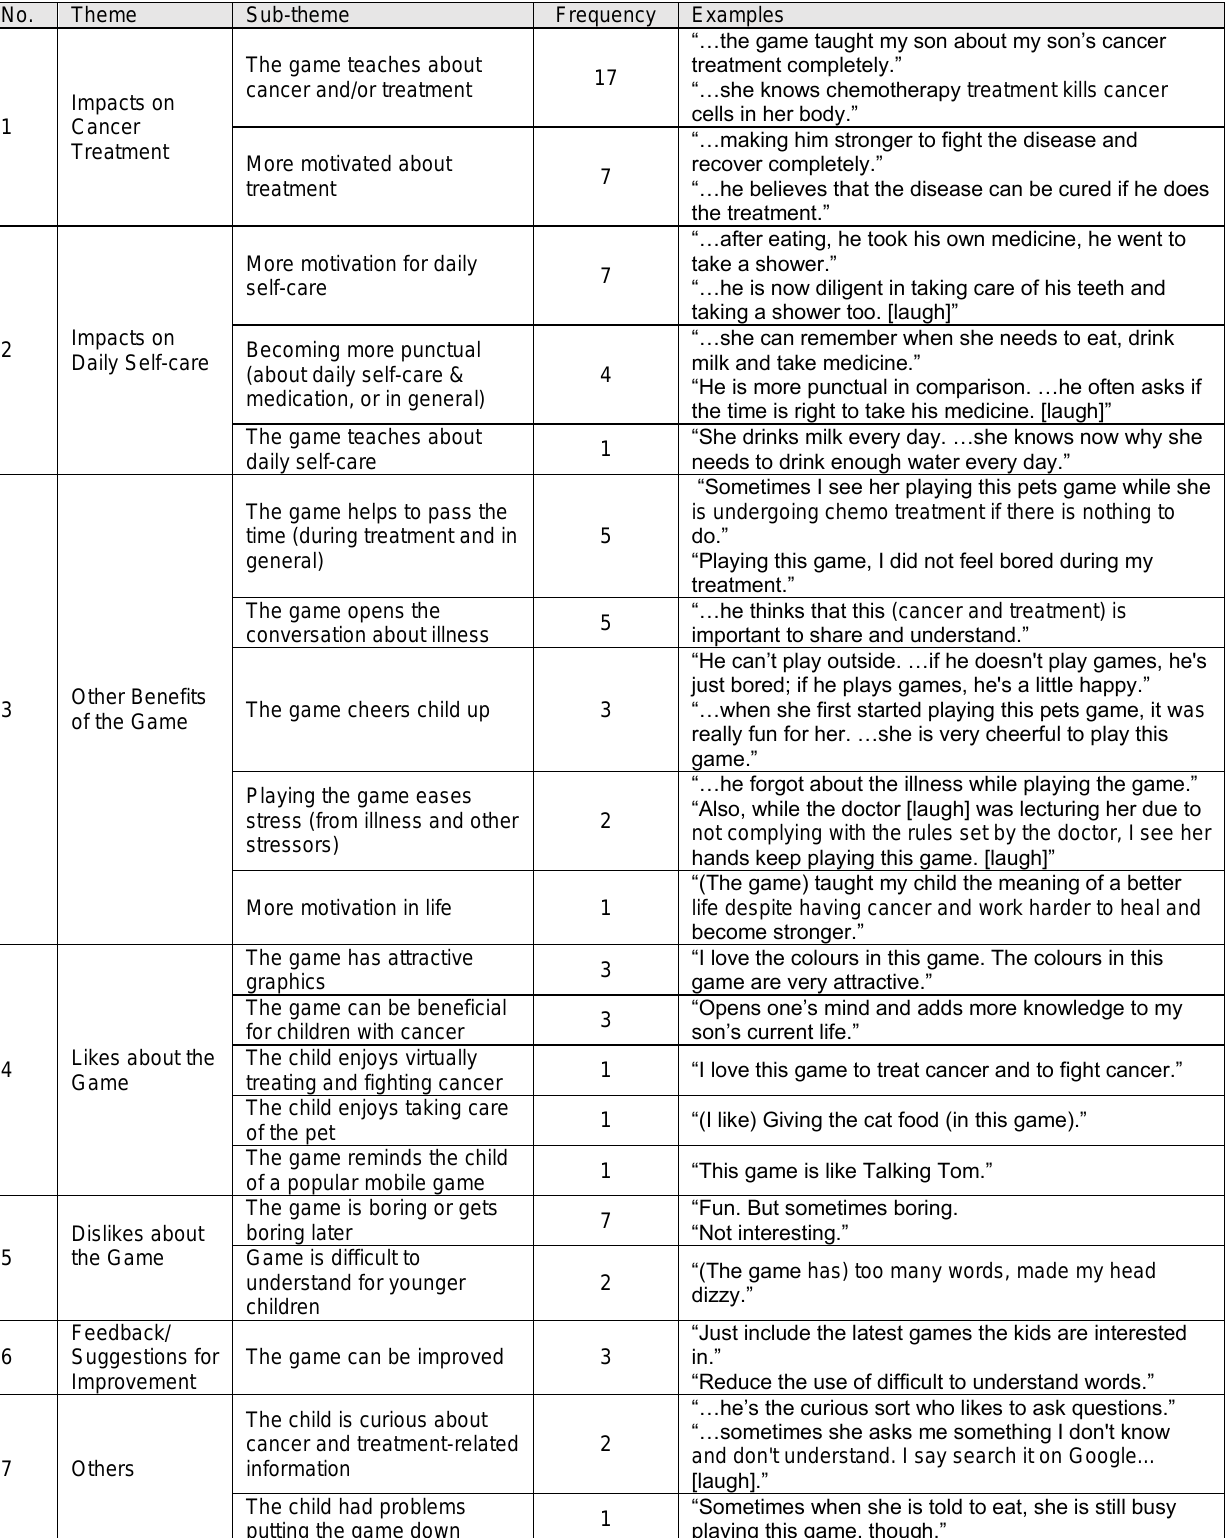
Table 4. Thematic Analysis - Coding Themes and Sub-theme Frequencies and Examples